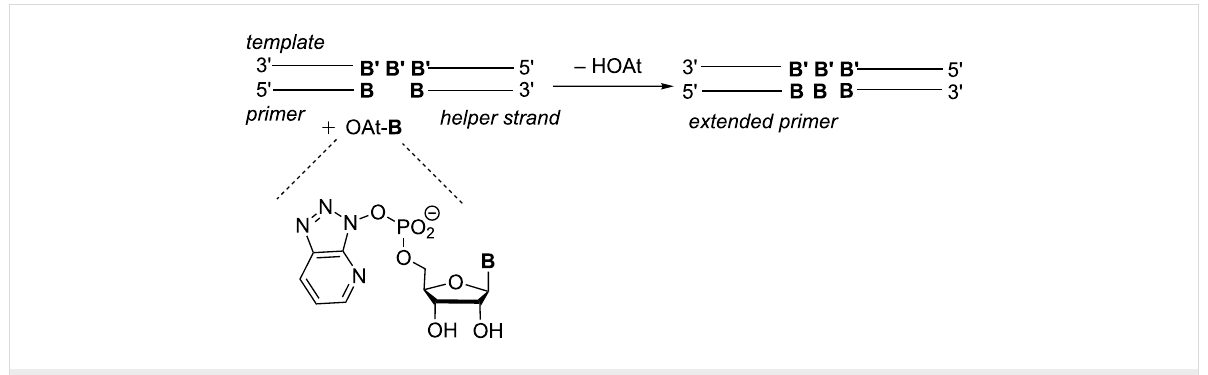
Figure 4: System used for studying the template effect with all 64 possible triplets at the extension site (B/B' =